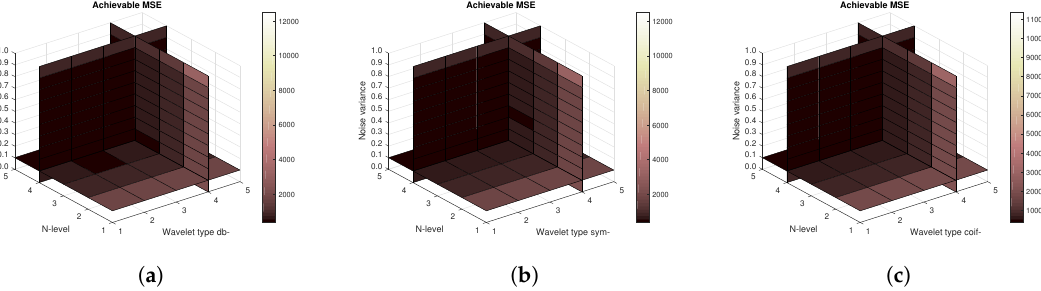
Figure 19. MSE in the presence of AWGN only for the CT scan from Figure 4 with use of three mother wavelet families—from left Daubechies ( a ), Symlet ( b ) and Coiflet ( c ).